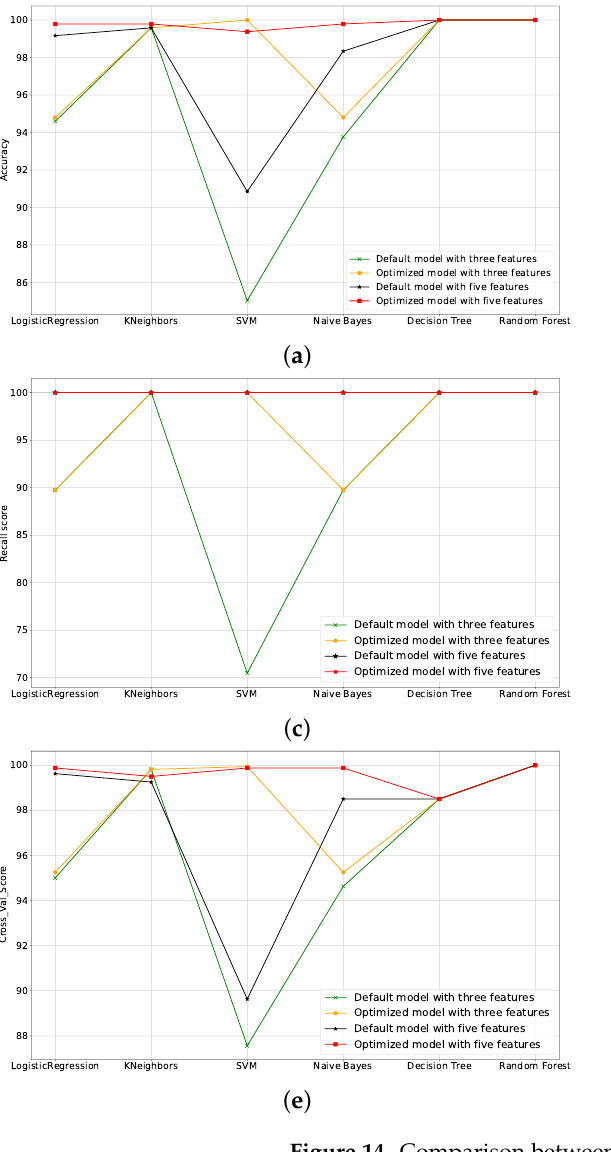
Default model with three features Optimized model with three features Default model with five features